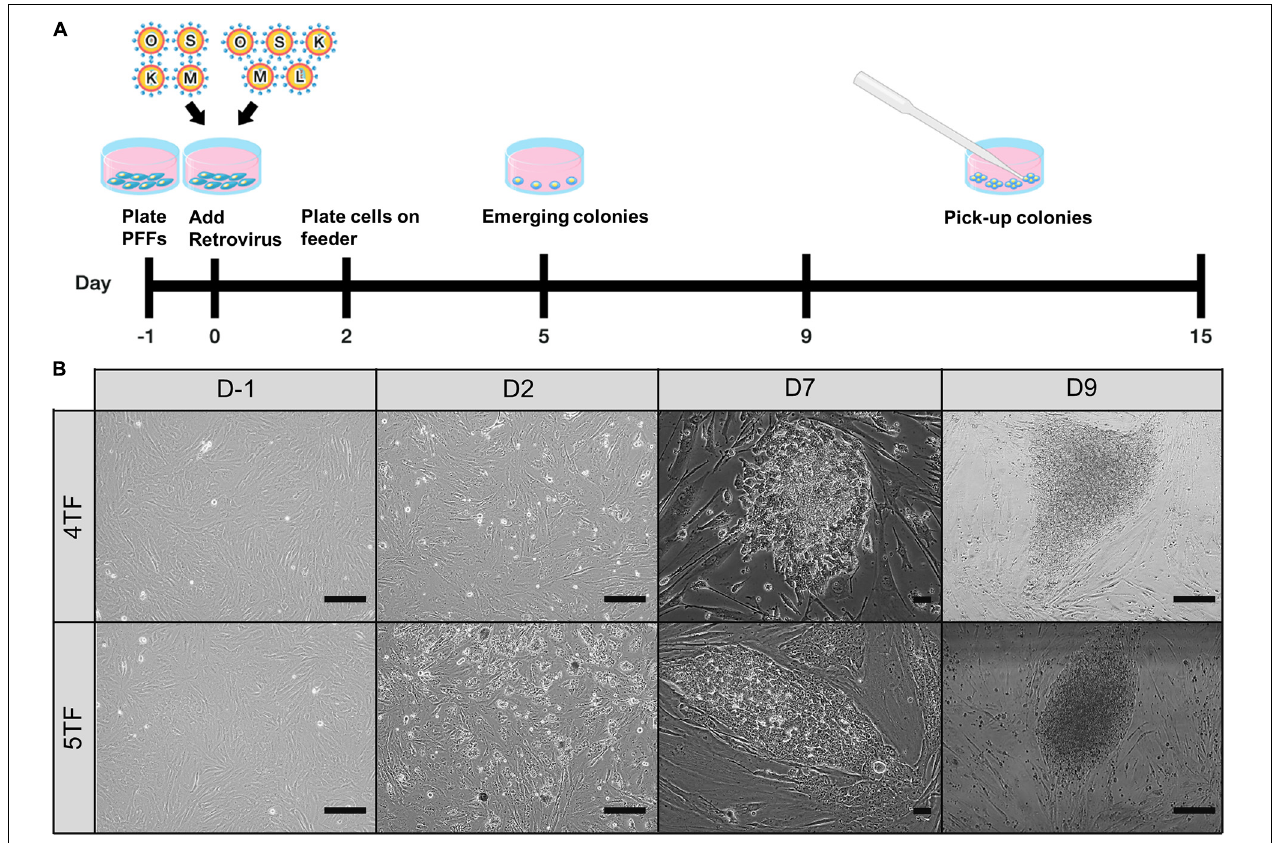
FIGURE 1 | Establishment of porcine-induced pluripotent stem cells (piPSCs). (A) Schematic diagram of the establishment of piPSCs. (B) The process of generation of 4TF-piPSC and 5TF-piPSC; scale bar, 50 µ m. 4TF, induction using OCT4, SOX2, KLF4, and C-MYC; 5TF, induction using OCT4, SOX2, KLF4, C-MYC, and